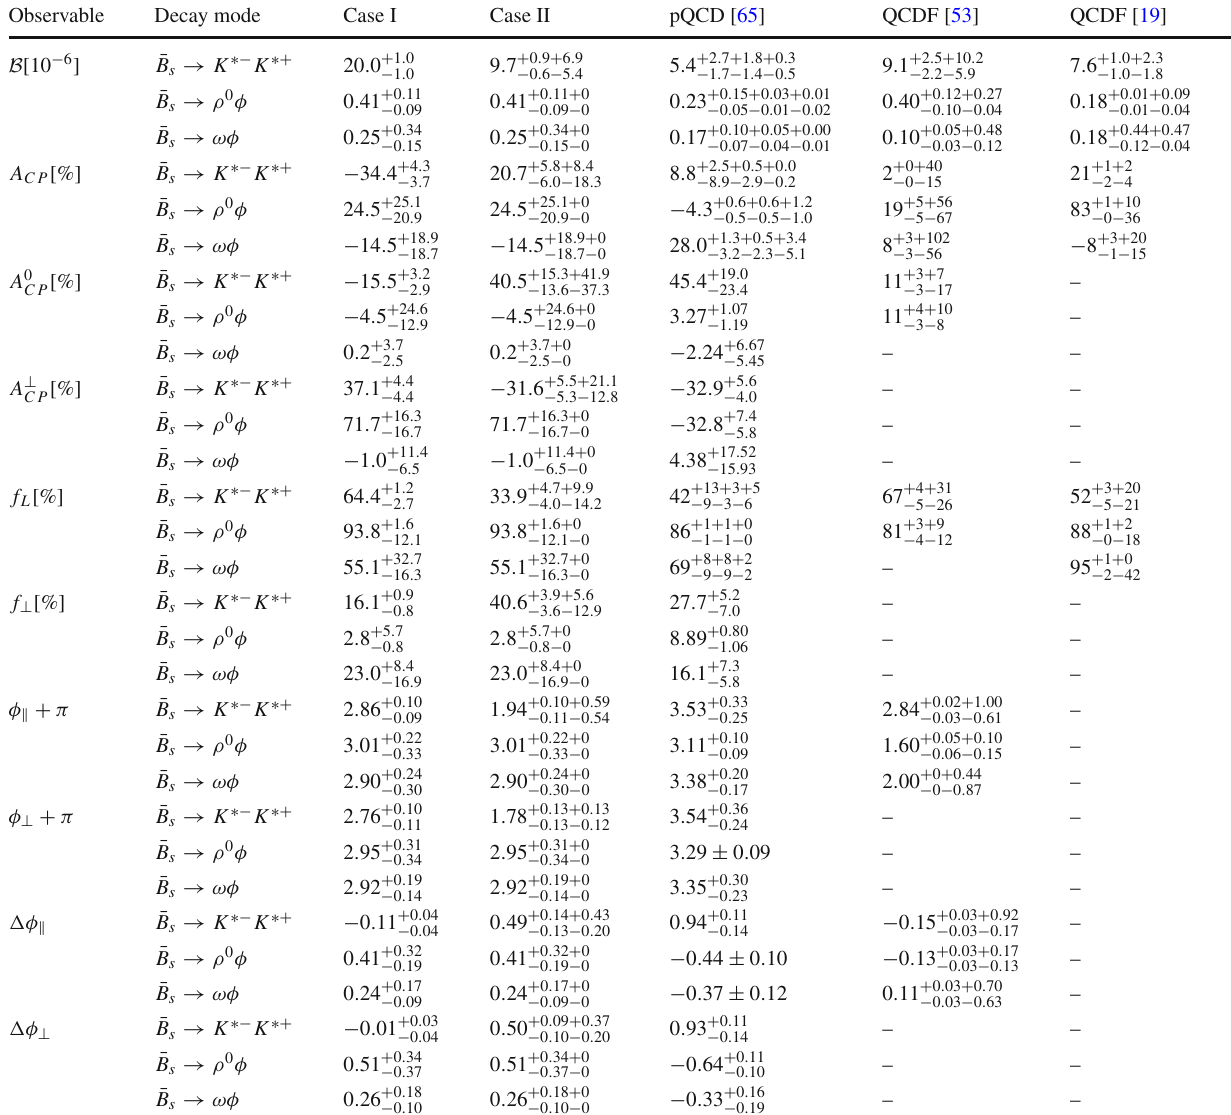
Table 5 Theoretical results for the b → s induced ¯ B s → K ∗− K ∗+ , ρ 0 φ and ωφ decays